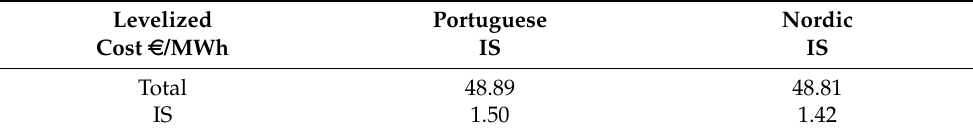
Table 2. Levelized energy costs of the wholesale market.